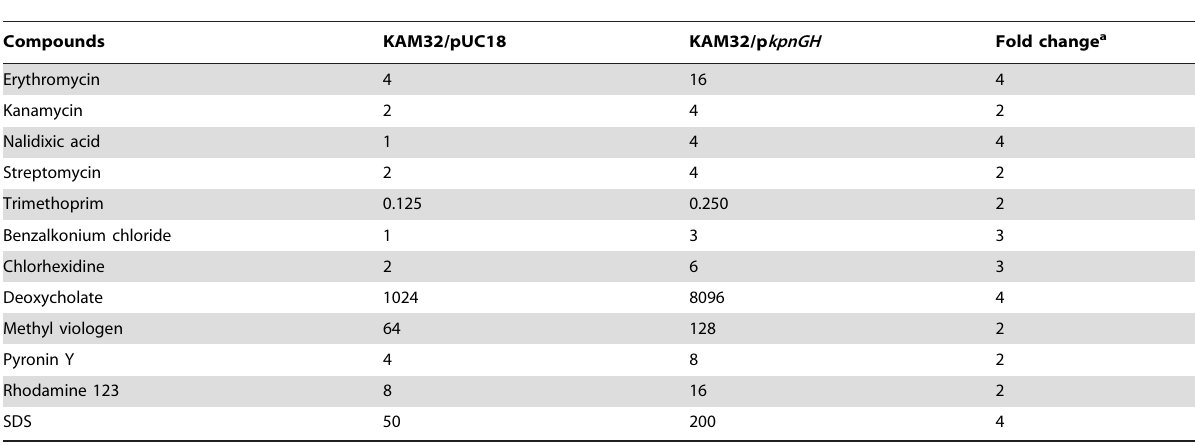
Table 2. Determination of MIC for E. coli KAM32/pUC18 and KAM32/p kpnGH.